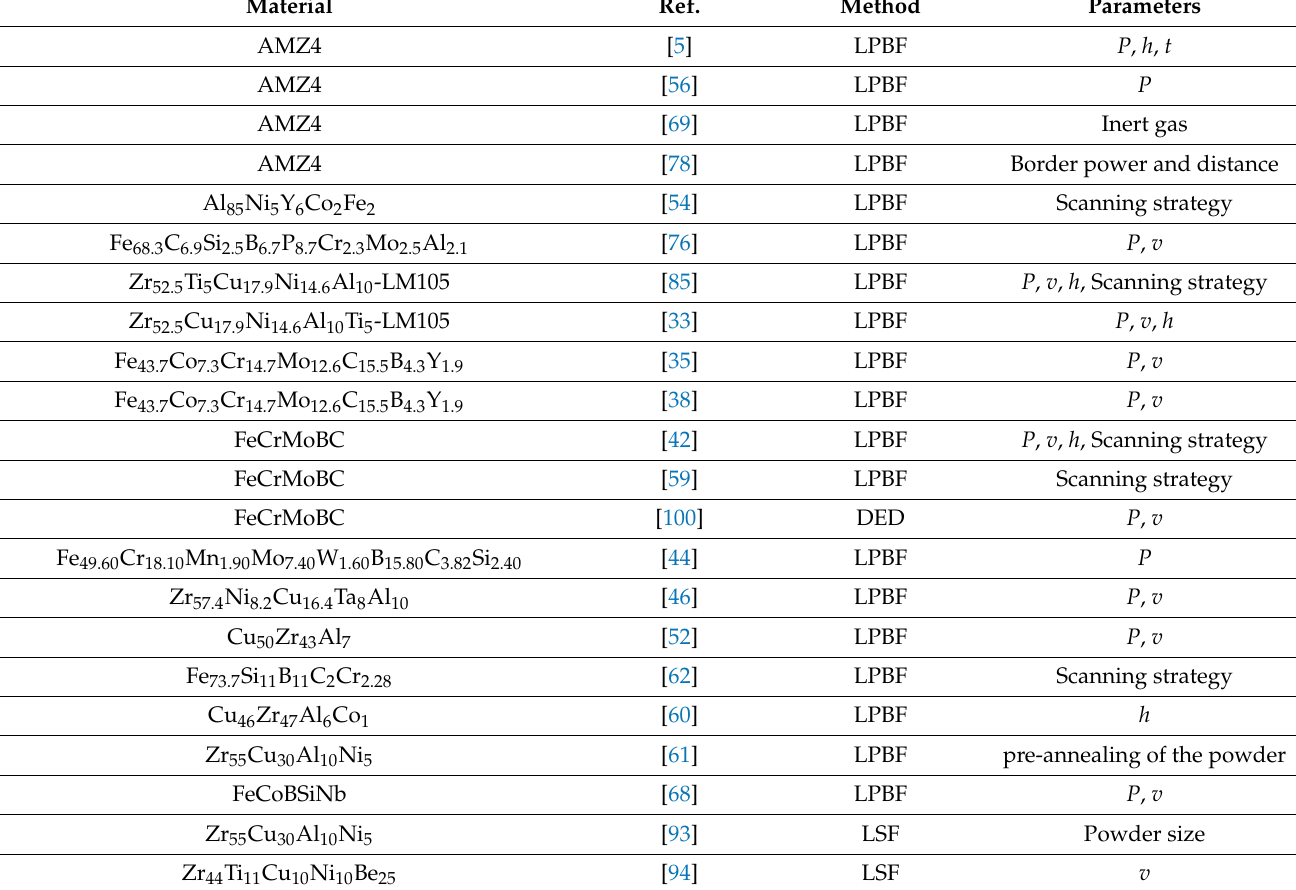
Table 2. Studied parameters used in AM of